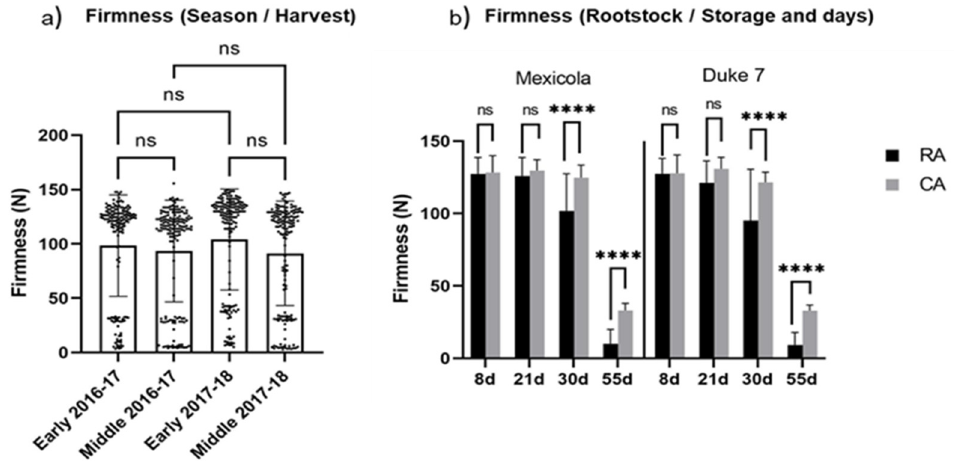
Figure 1. ( a ) Average firmness monitoring of Hass avocado fruit from “Mexicola” and “Duke 7” rootstocks from early (23–26% dry matter) and middle (>26–30% dry matter) harvests during two seasons, 2016/2017 and 2017/2018, and stored up to 55 d in regular air (RA, 5 °C) and controlled atmosphere (CA, 4 kPa O 2 and 6 kPa CO 2 at 5 °C). A two-way ANOVA was performed to evaluate whether there were significant differences between harvests and seasons. Significant differences are represented by an asterisk (ns, not significant). ( b ) Average firmness monitoring of Hass avocado fruit from “Mexicola” and “Duke 7” rootstocks stored up to 55 d in regular air (RA, 5 °C) and in controlled atmosphere (CA, 4 kPa O 2 and 6 kPa CO 2 at 5 °C). A three-way ANOVA was performed considering rootstock, storage conditions and days of storage as factors. Significant differences are represented with an asterisk (****, p -value < 0.0001; ns, not significant).